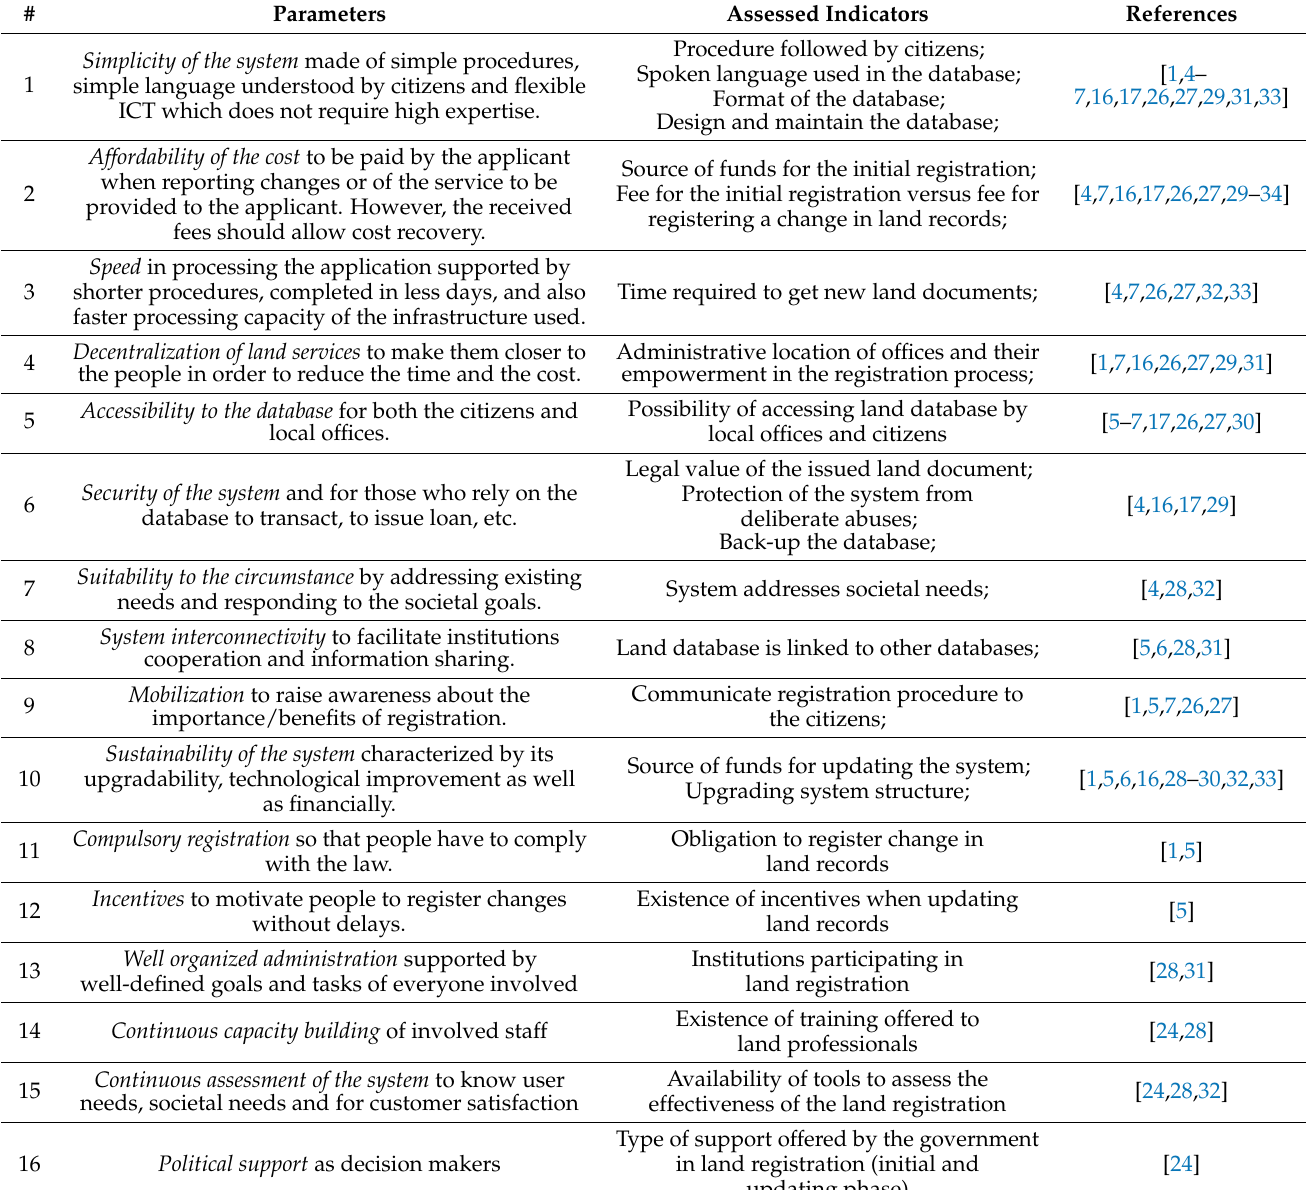
Table 2. Parameters and indicators to be considered when updating an